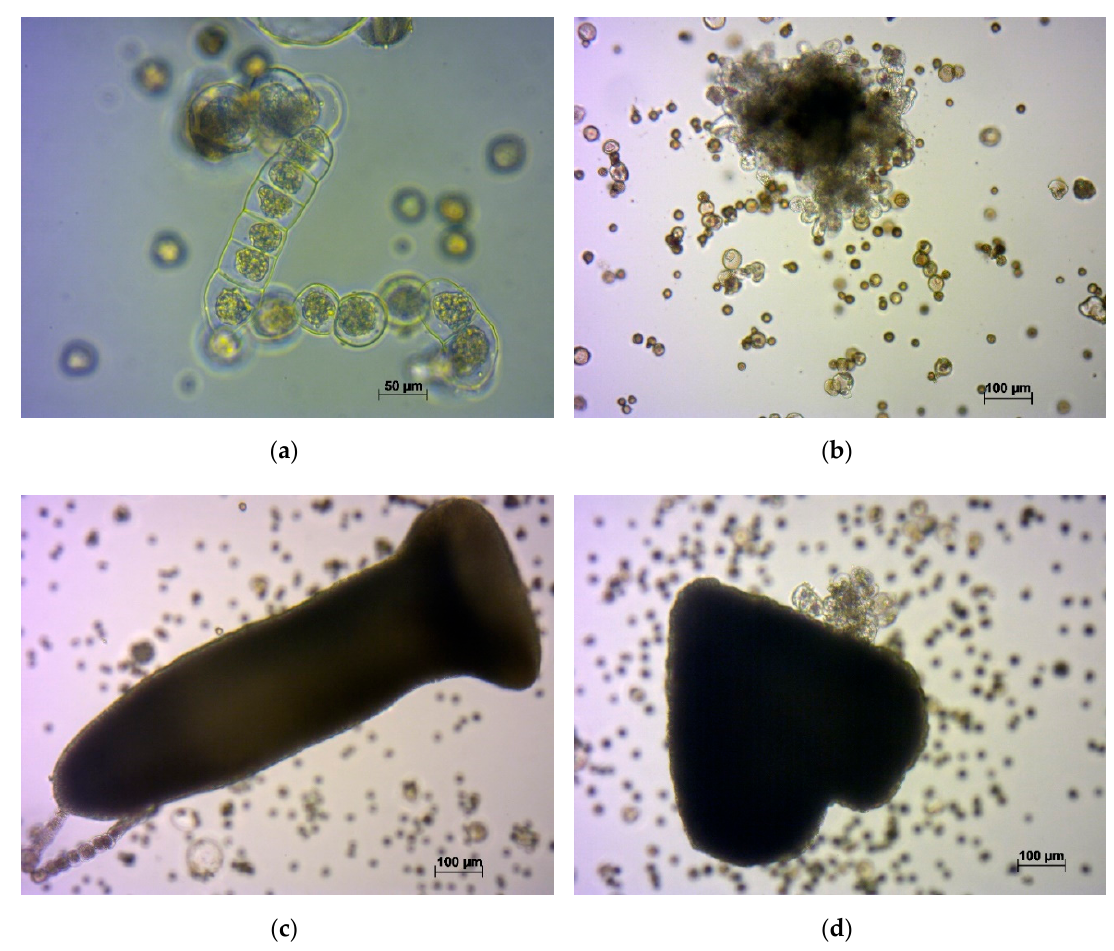
Figure 3. The in vitro development of isolated microspores: ( a ) Suspensor-like structure; ( b ) callus; ( c ) embryo formed from a suspensor-like structure; and ( d ) embryo developed from a microspore without formation of a suspensor-like structure.